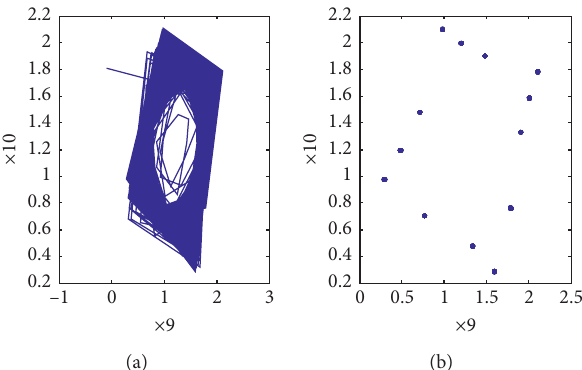
Figure 28: ω � 237 and k � 0with the Coulomb model when t ∈ 0 . 05 0 . 0581 􏼂 􏼃 . (a) Phase trajectories. (b) Poincare maps. w